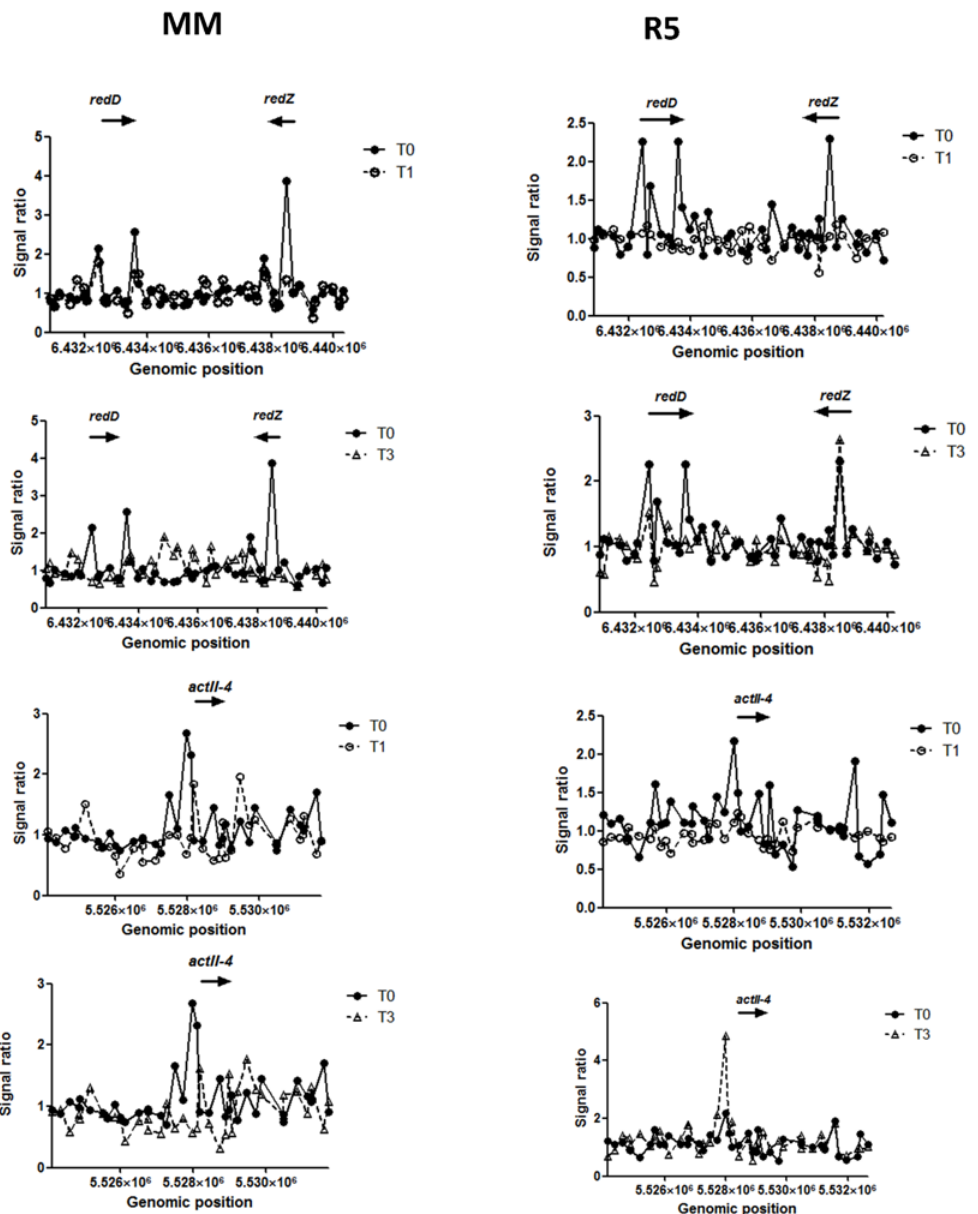
Fig 2. Chip-on-chip data for selected DasR targets detected in the GlcNAc induction experiment. Samples were collected prior to (T 0 , closed circles) and 30 (T 1 , open circles), 60 (T 2 ) or 120 min (T 3 , open triangle) after GlcNAc addition. Plots indicate change in affinity of DasR for the promoter regions of the pathway-specific activator genes for the biosynthesis of actinorhodin ( actII- ORF4) and prodiginine ( redD , redZ ) upon addition of GlcNAc (25 mM) to liquid- grown NMMP (left panel) or R5 (right panel) cultures. Arrows indicate the orientation of the targeted genes. Note that the y-axis (signal ratio) varies between the